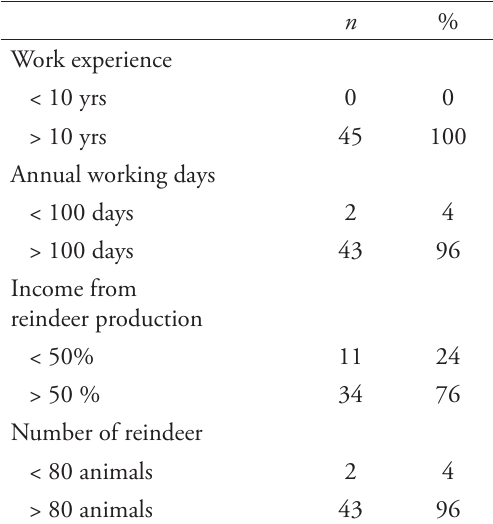
Table 2. Background information about the inter- viewees: work experience and economic importance of reindeer husbandry. n is the number of managers in each